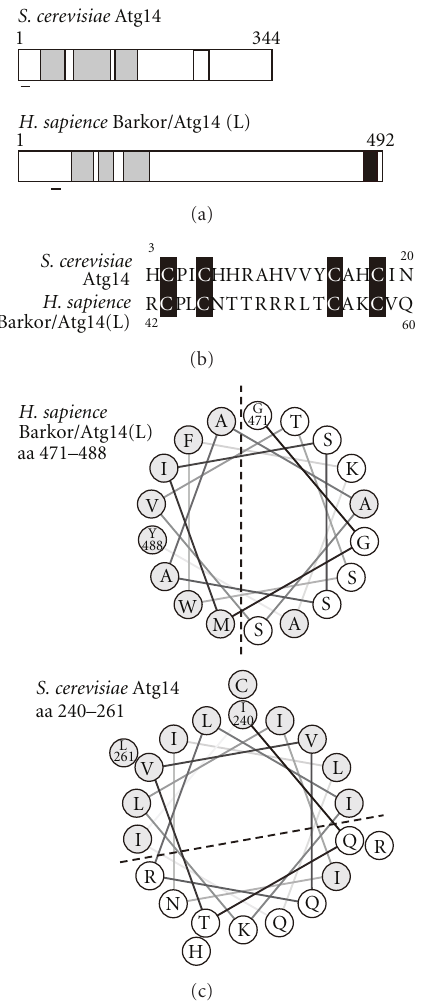
Figure 2: Structure of Atg14. (a) Diagram of yeast Ag14 and human Barkor/Atg14(L). Boxes in gray indicate coiled-coil domains. Bars indicate a position of the conserved cysteine residues. Box in black is the recently found BATS domain containing an amphiphilic helix. Although the BATS domain is not conserved in yeast Atg14, a predicted amphiphilic alpha helix is present within the C-terminal half (white box). (b) The amino acid sequence of the N-terminal motif containing the conserved cysteine residues. The conserved cysteine residues are highlighted. (c) Helical wheel representation of the predicted amphiphilic alpha helix within the C-terminal half of Barkor/Atg14(L) and yeast Atg14. Hydrophobic residues are shown in